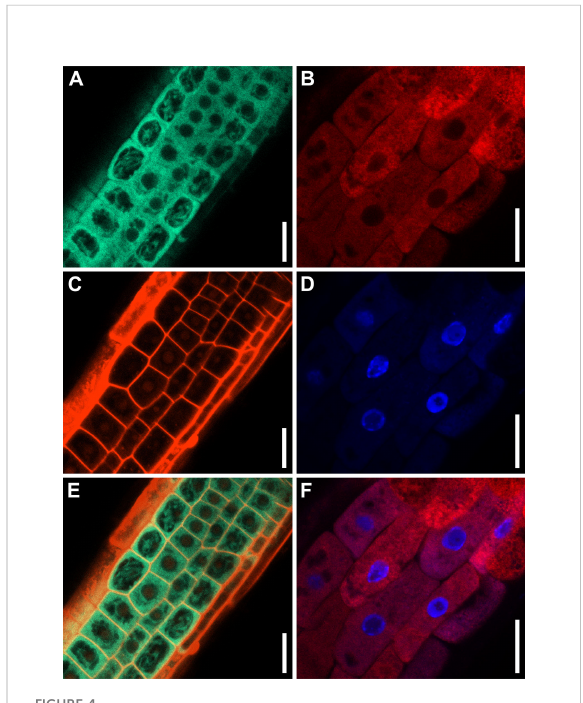
FIGURE 4 Subcellular localization of the ABCE2 protein in cells from the root elongation zone. Confocal laser scanning micrographs of (A, C, E) L er 35S pro :ABCE2:GFP and (B, D, F) api7-1 35S pro :ABCE2:YFP transgenic plants. Fluorescent signals correspond to (A) GFP, (B) YFP, (C) propidium iodide, and (D) DAPI staining, and the overlay of (E) GFP and propidium iodide, and (F) YFP and DAPI. Pictures were taken (A, C, E) 14 and (B, D, F) 5 das. Scale bars indicate 20 m